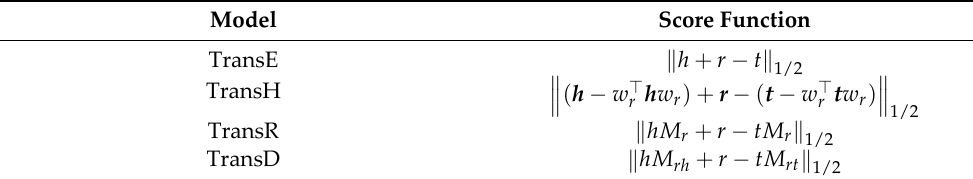
Figure 8. Experimental structure diagram. Table 4. Definition of scoring functions for TransE, TransH, TransR,